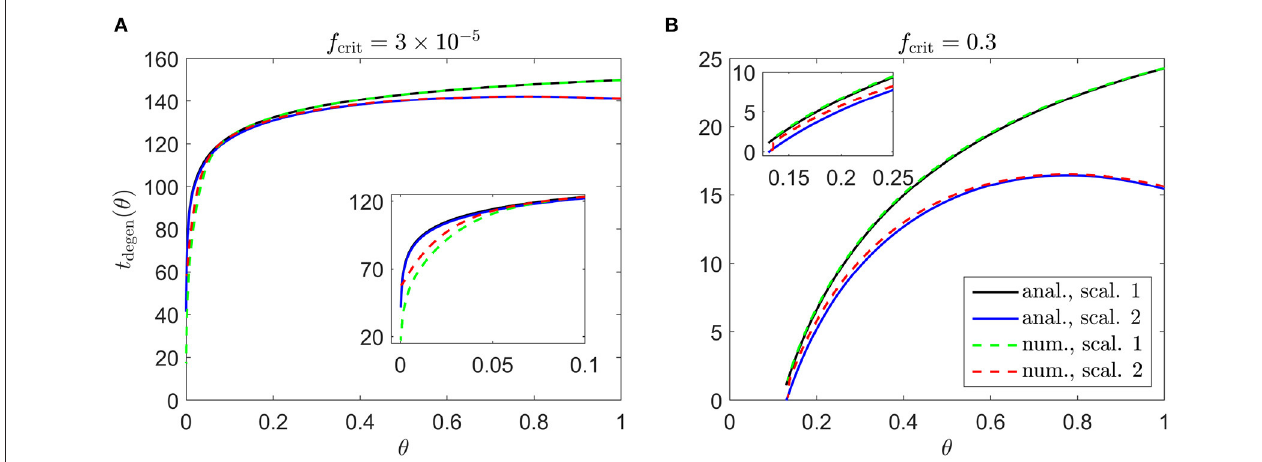
FIGURE 4 | Cone degeneration profiles. Graphs show the time, t degen ( θ ), at which cones degenerate due to RdCVF deprivation, with constant rate of mutation-induced rod degeneration, φ r = 7.33 × 10 − 2 , and constant TF threshold concentrations: f crit = 3 × 10 − 5 (A) and f crit = 0.3 (B) . The solid black and dashed green curves correspond to Scaling 1 ( α = 7.01 × 10 4 and β = 1.79 × 10 6 ), while the solid blue and dashed red curves correspond to Scaling 2 ( α = 7.01 × 10 2 and β = 1.79 × 10 4 ). The black and blue solid curves are analytical approximations, obtained by plotting Equations (6) and (9), respectively, while the green and red dashed curves are p c ( θ , t ) / ˜ p c ( θ ) = 0.99 contours, obtained by solving Equations (1–5) using the method of lines with 401 mesh points. (A) Simulation spans ∼ 17.7 years in dimensional variables; (B) simulation spans ∼ 2.8 years in dimensional variables. Insets show magnified portions of each graph. Cone degeneration initiates at the fovea ( θ = 0) in (A) and at θ = 0.13 in (B) , spreading peripherally (rightwards) in both cases. Degeneration occurs earlier in (B) than in (A) and for Scaling 2 than for Scaling 1 (except near the fovea in (A) ). Remaining parameter values as in Table 2